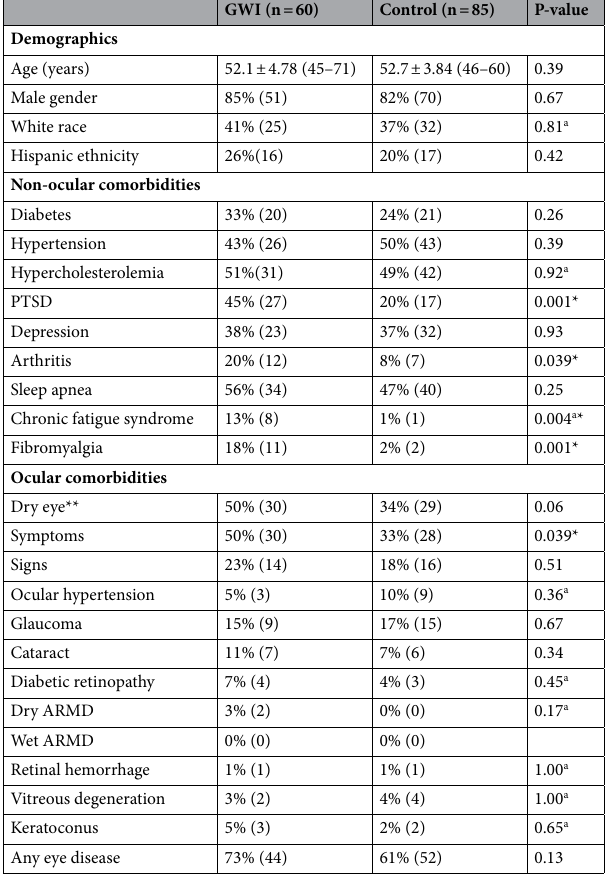
Table 1. Demographic and comorbidities of the study population. Continuous variables are expressed as mean ± standard deviation (minimum–maximum). Categorical variables are expressed as percent (n). Mann– Whitney U test was used for all continuous variables. Pearson Chi Square was used for all categorical variables unless otherwise noted. GWI Gulf War Illness, Control Individuals who served in 1990–91 who do not meet criteria for GWI, ARMD age-related macular degeneration, SD standard deviation, n number in group, PTSD post-traumatic stress disorder. *Statistically significant difference at a p-value < 0.05 between GWI and control. **Symptoms or signs. a Fisher’s Exact